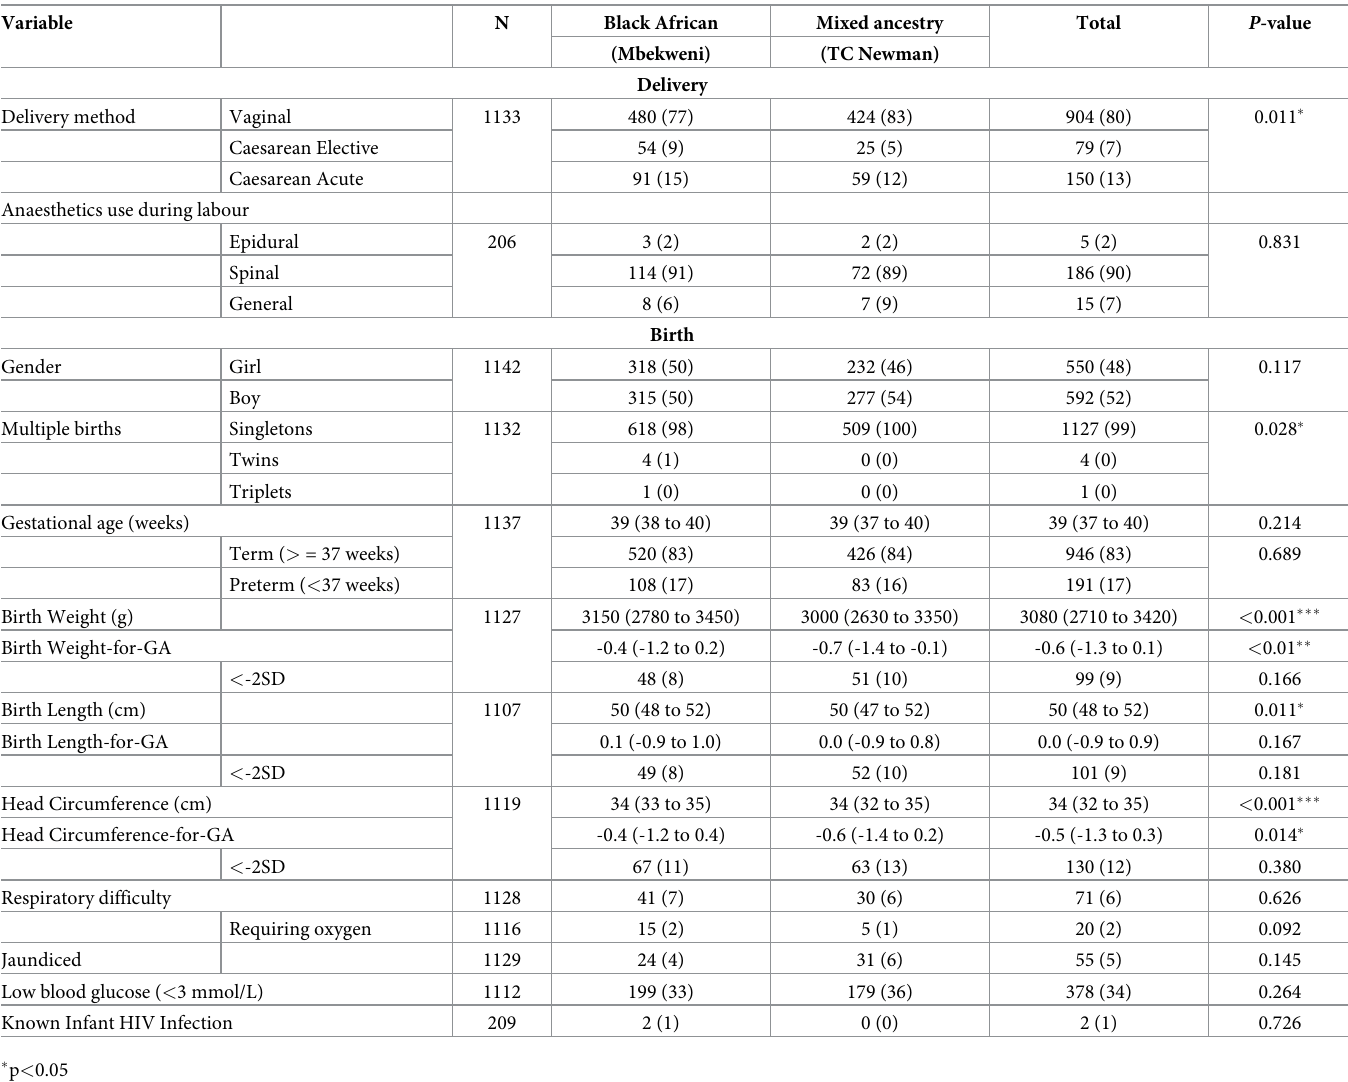
Table 2. Birth outcomes of the 1143 births including 4 sets of twins and 1 set of